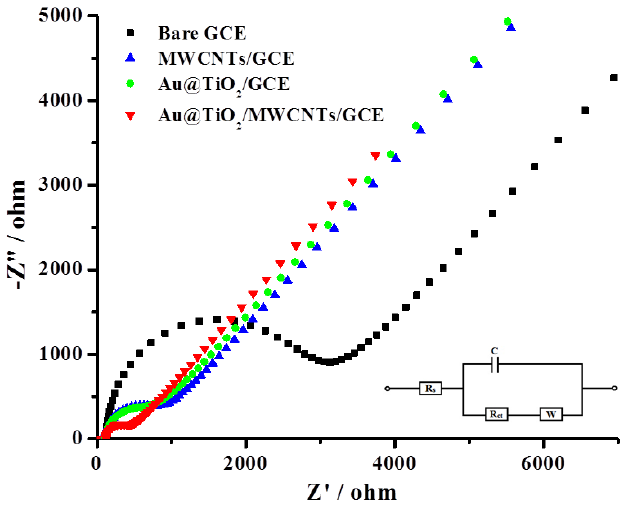
Figure 9. Nyquist plot for modified (labeled) and bare glassy carbon electrodes in 5